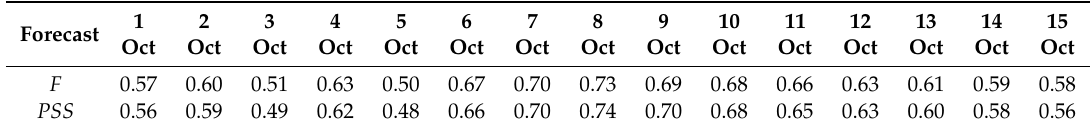
Table 4. Statistics of the simulated peak flood extents compared to the published extents.